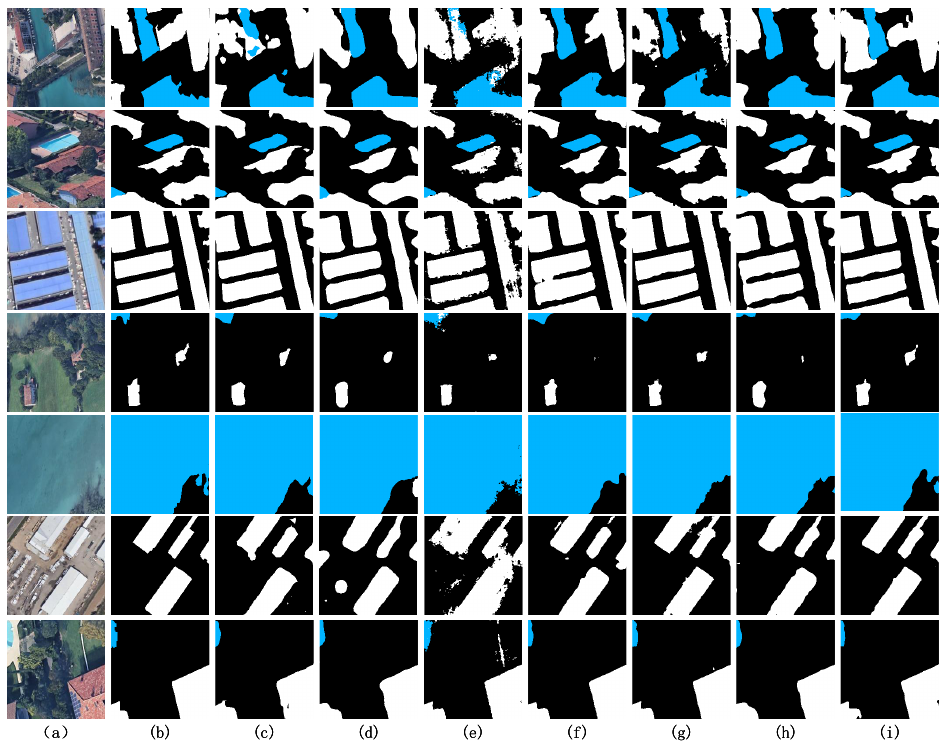
Figure 10. Comparison of different models on land cover dataset. ( a ) Real image; ( b ) label; ( c ) BiseNetv2; ( d ) FCN8s; ( e ) SegNet; ( f ) OCRNet; ( g ) UNet; ( h ) PSPNet; ( i ) our segmentation